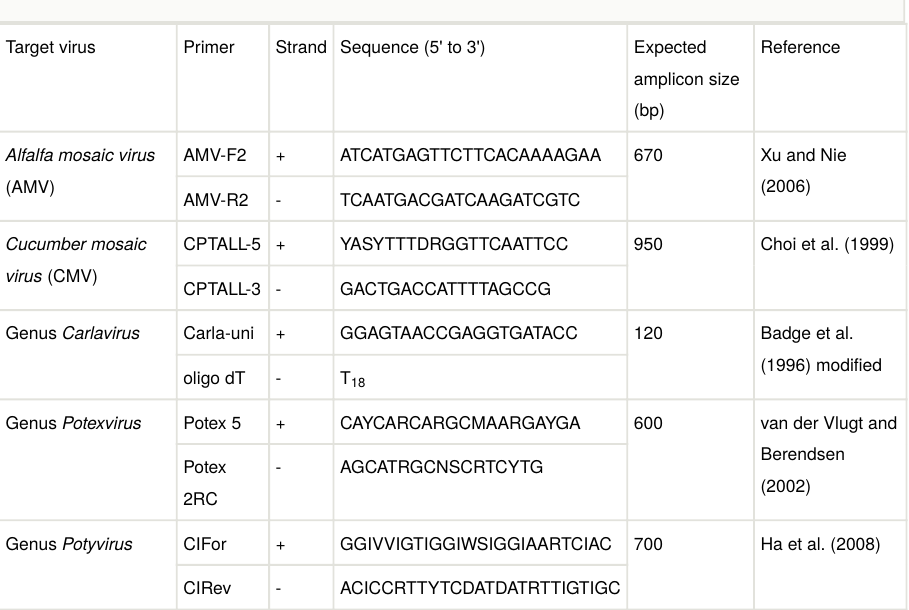
Table 1. Primers used for virus detection in this study.